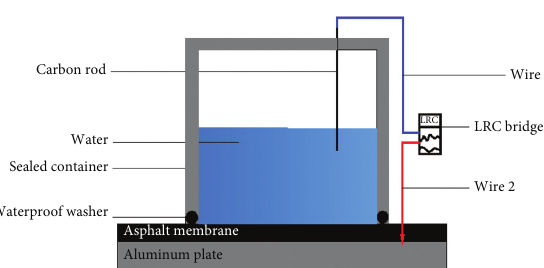
Figure 4: The general schematic diagram of the test